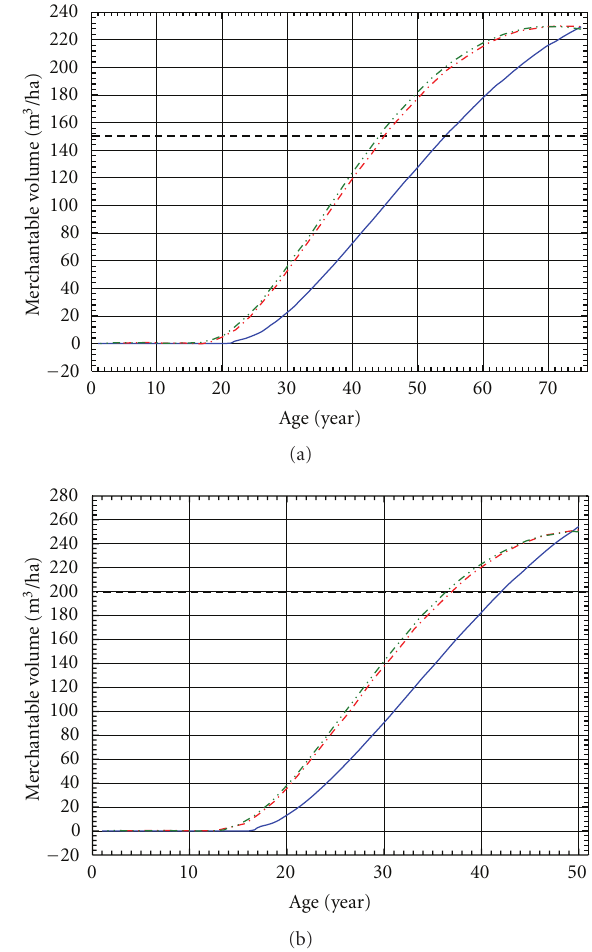
Figure 4: Type I response pattern as reflected in the piece size-age relationship for poor-medium (a) and good-excellent (b) site quali- ties. Regime denotations are given in Figure 3. Note that the inter- section of the horizontal dotted line denoting the specified oper- ability criterion with a production curve indicates the earliest age at which the piece size operability criterion is attained.